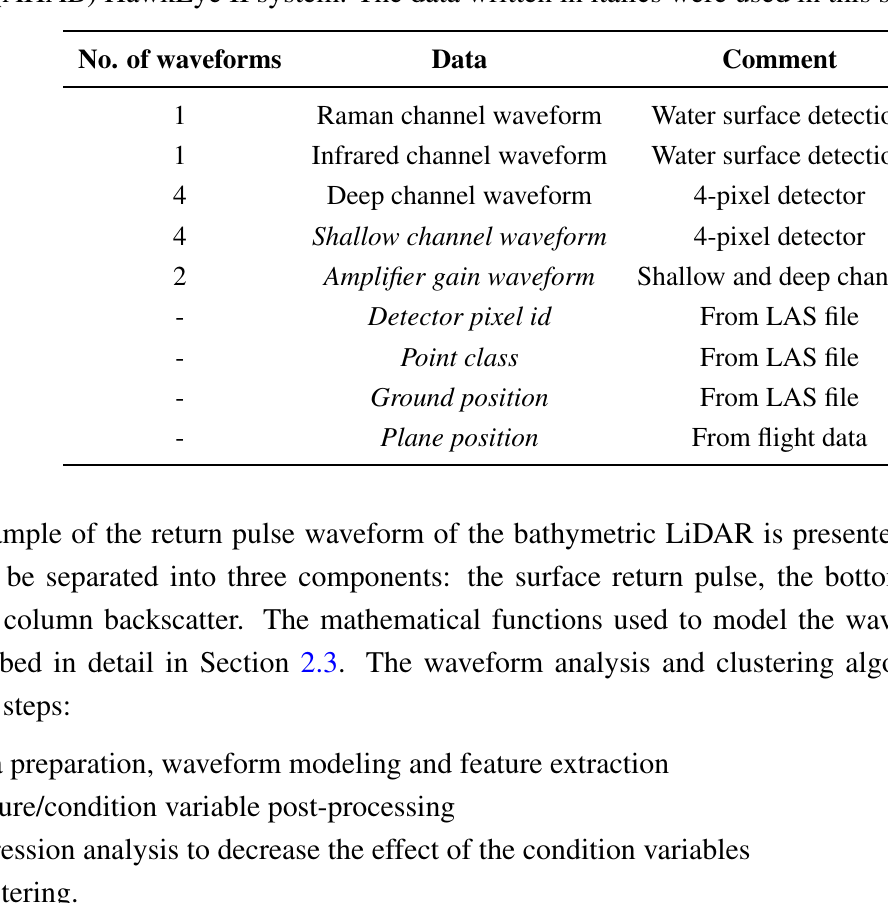
Table 1. Data content for each LiDAR pulse obtained from the Airborne Hydrography AB(AHAB) HawkEye II system. The data written in italics were used in this